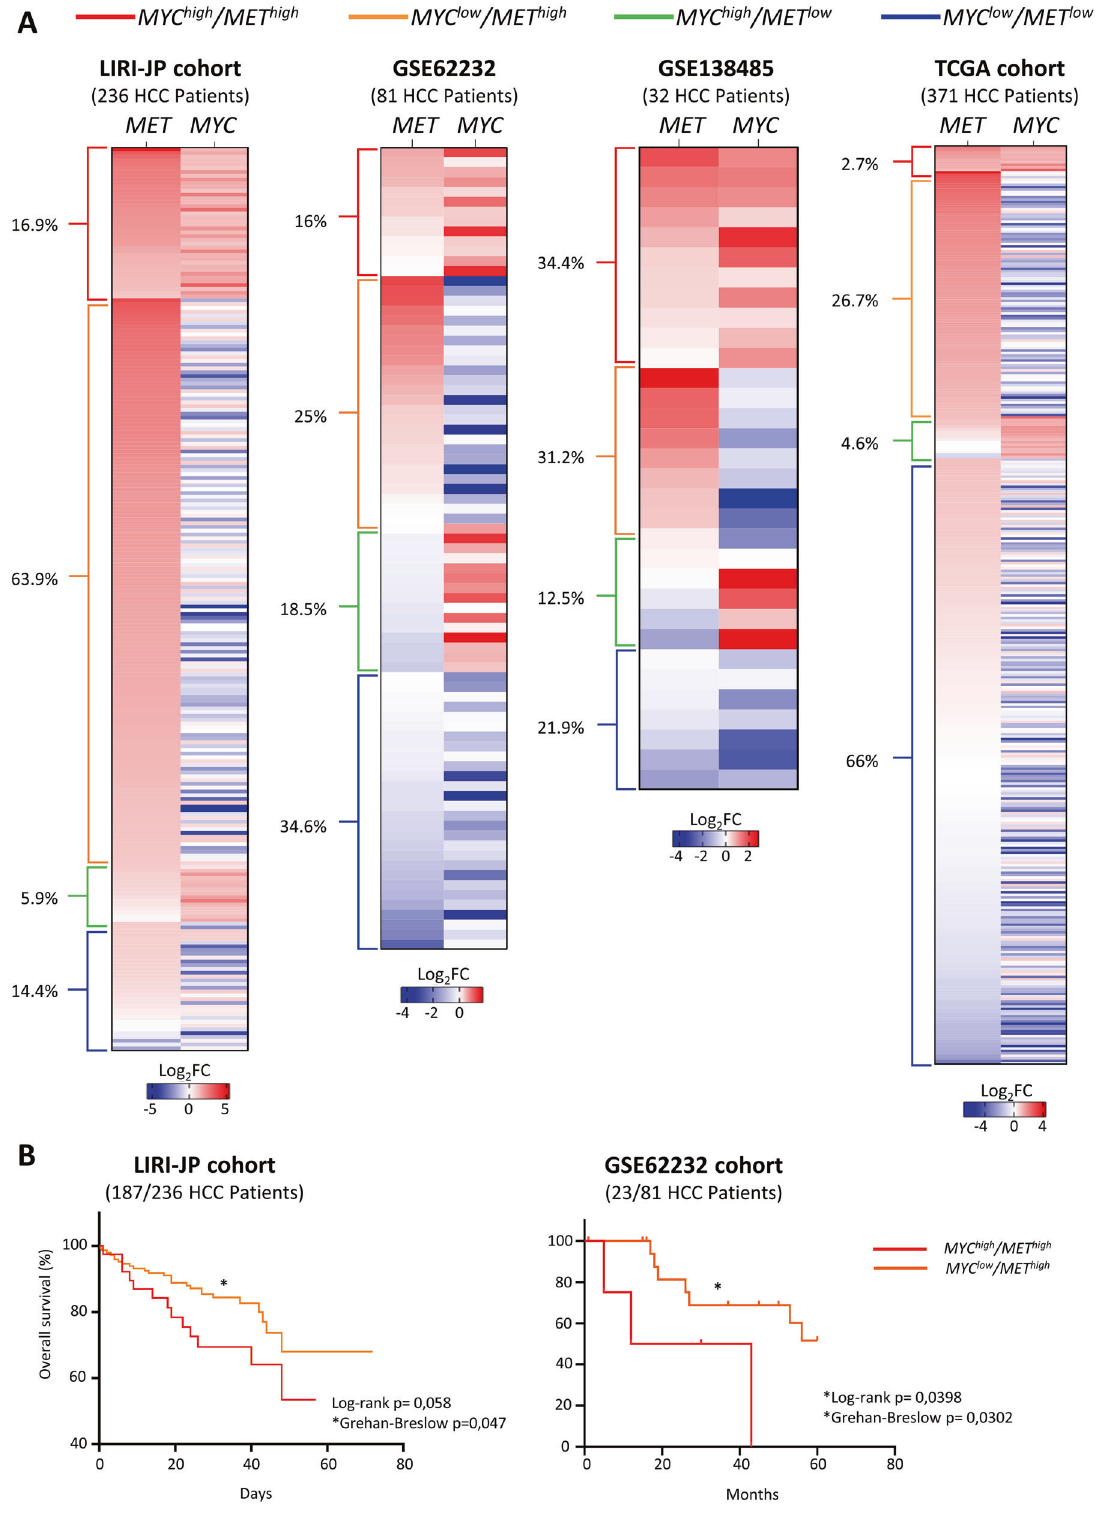
Fig. 1 High expression levels of MYC and MET co-occur in a subset of HCC patients. A Heatmap reporting four different cohorts (LIRI-JP, TGGA-LIHC, GSE62232, and GSE138485) with HCC patients organised according to the expression levels of MYC and MET , and subdivided into four subgroups: MYC high /MET high , MYC low /MET high , MYC high /MET low , and MYC low /MET low . The percentage of patients in each subgroup is indicated on the left of each heatmap. B Kaplan – Meier curve showing the overall survival of LIRI-JP (left) and GSE62232 (right) patients with MYC high / MET high versus MYC low /MET high . Note that for the GSE62232 cohort, survival information was available for only four patients of the MYC high / MET high group. Statistical analysis was performed with Grehan – Breslow.